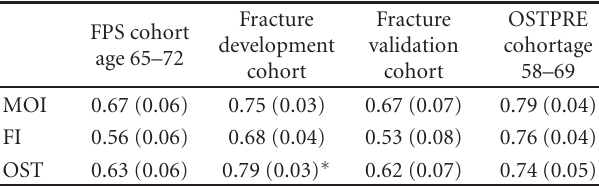
Table 3: AUC values (standard error) for MOI, FI, and OST with osteoporosis (BMD-T-score ≤ − 2.5) at the femoral neck in the development FPS (age 65–72, n = 434) and fracture cohorts (age 45–79, N = 300) and in the validation fracture cohort ( N = 200) and OSTPRE validation cohort (age 58–69, n = 943).